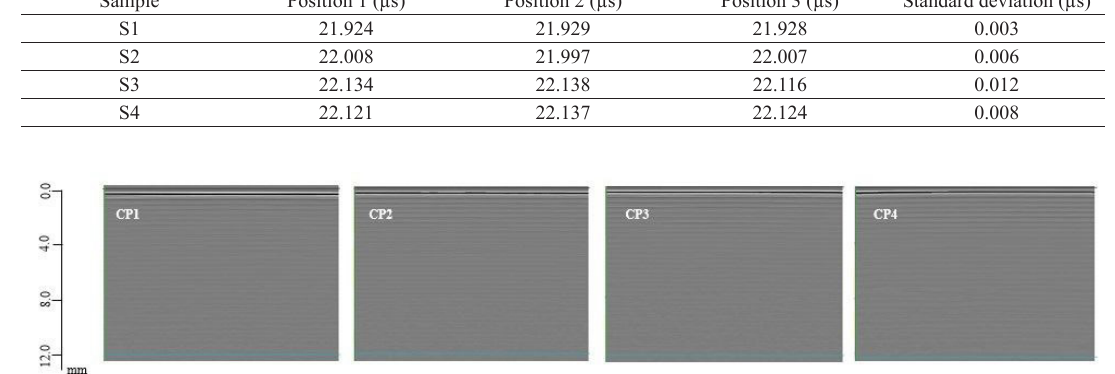
Figure 7. B-Scan images of the samples without defects – Group CP. Scale shows the depths along direction z.